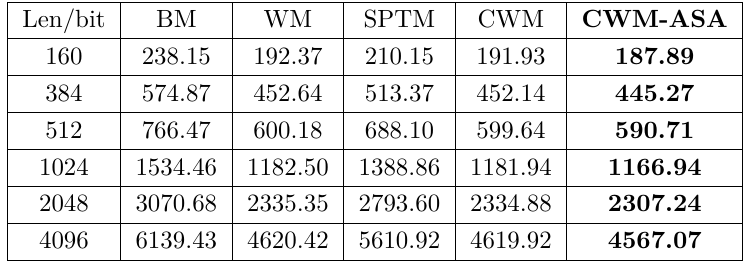
Table 2: Average addition chain lengths of random integers by bit-length.